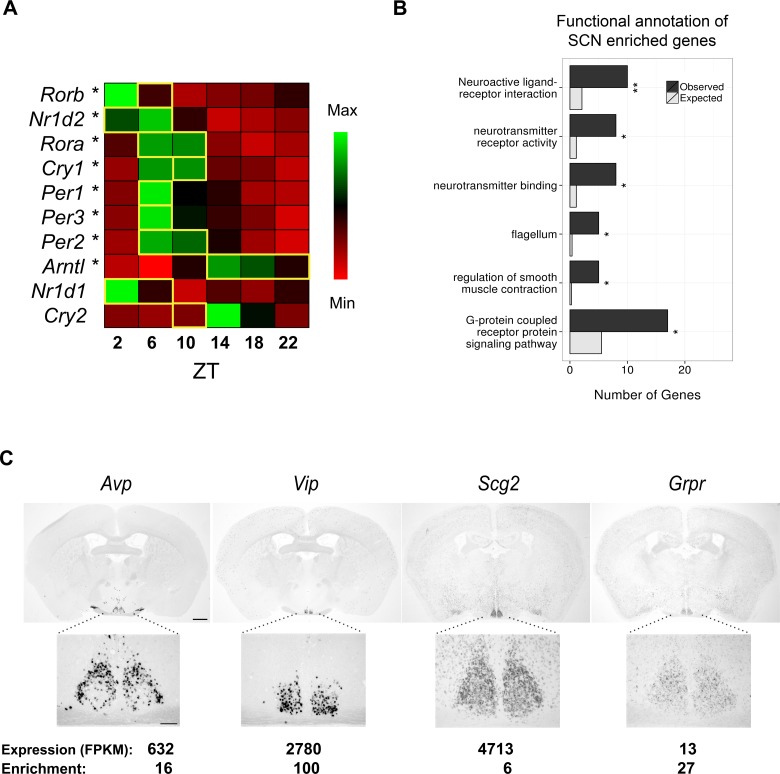
RNA-seq data of laser-capture microdissection (LCM) suprachiasmatic nucleus (SCN) samples recapitulate the cycling of clock gene expression and identify known and novel SCN enriched genes.(A) Heatmap showing mean expression of key clock genes in the SCN across circadian time. The majority (8/10) show significant cycling (DESeq2 and JTK Cycle; *q < 0.05) and peak at the expected timepoint denoted by a yellow box (Ko and Takahashi, 2006). (B) Statistically significant Gene Ontology (GO) enrichments for SCN enriched genes (q < 0.05). Bars represent the number of genes of a given category expected by chance among SCN enriched genes (grey) versus those observed (black). q-values: *q < 0.05, **q < 0.01, ***q < 0.001. (C) In situ hybridisation (ISH) of four SCN enriched genes at ZT6 in the wild-type brain. Scale bar: 0.5 mm (low magnification); 0.2 mm (high magnification).